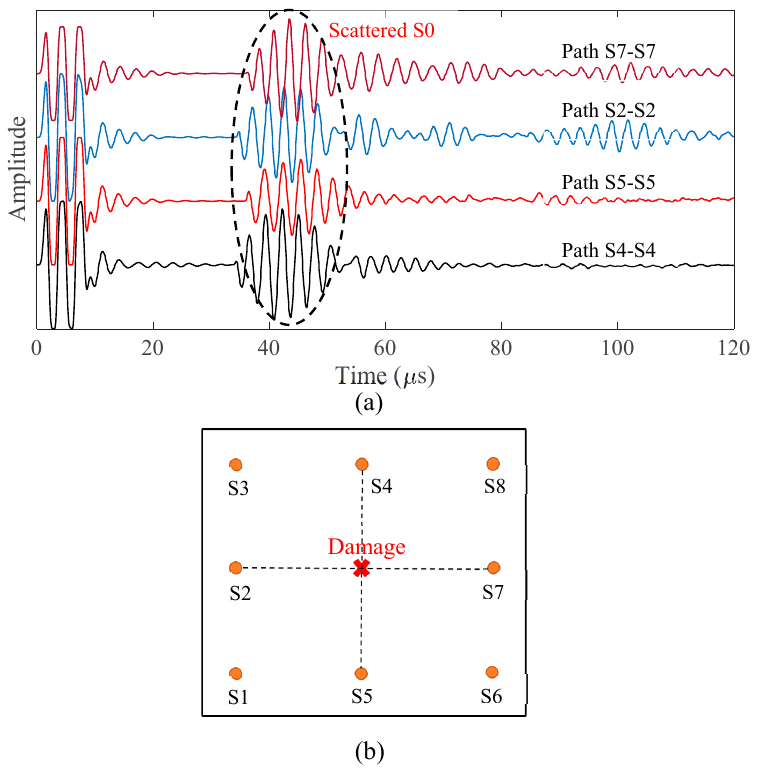
Figure 15. The new methodology for the localization of damage point: ( a ) pulse-echo signals of the sensing paths S2-S2, S4-S4, S5-S5, and S7-S7; ( b ) determining the location of damage.